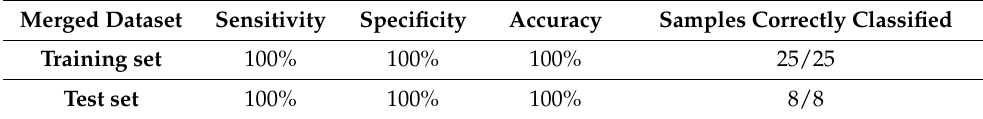
Table 2. Statistical figures of merit (sensitivity, specificity, and accuracy) for the random forest model obtained in cross-validation on the training set and validation on the test set. Numbers of samples correctly classified are also